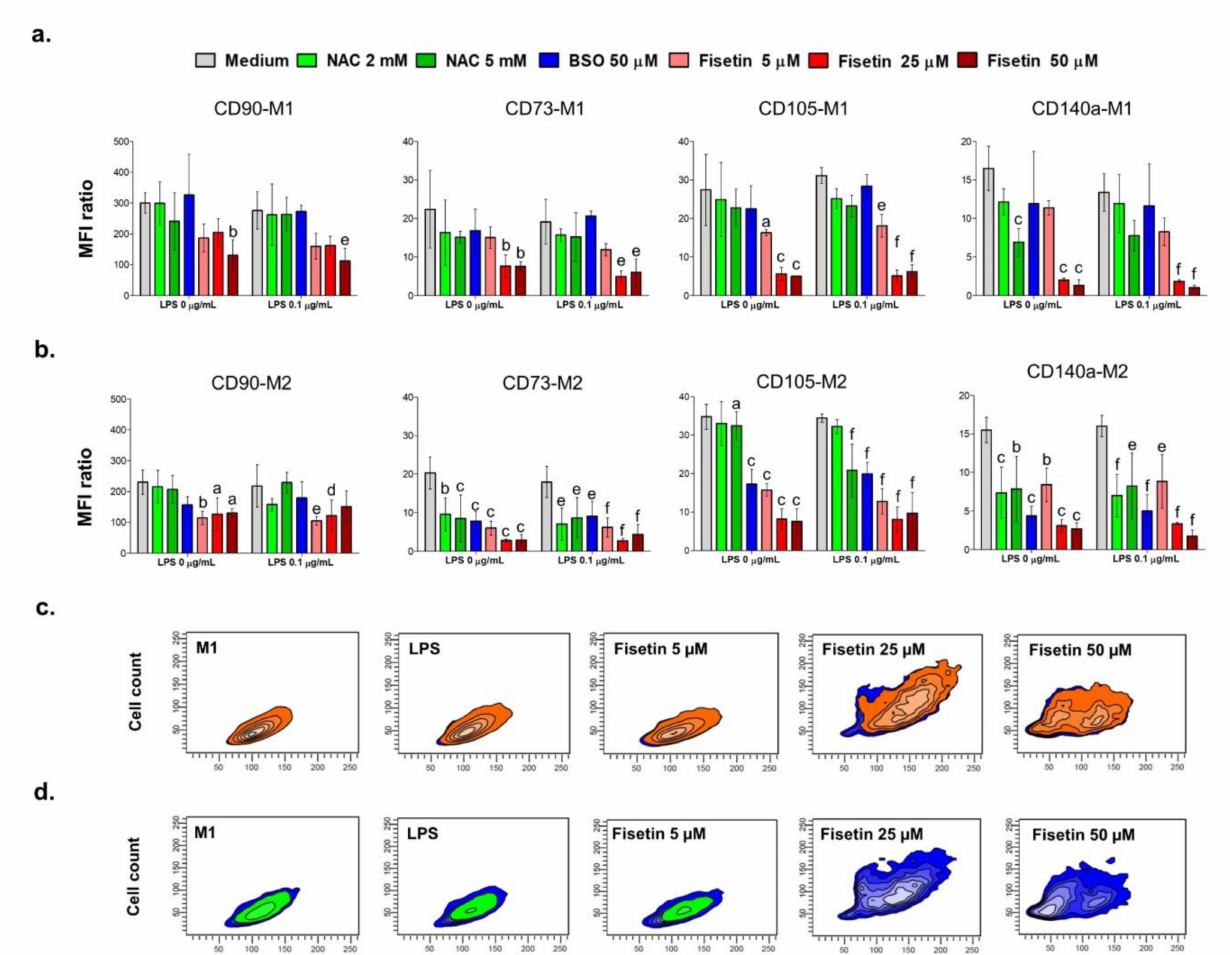
Figure 3. Immunophenotypic profile of human pulp cells. Cell cultures were treated under various experimental conditions for 3 days. Mean fluorescence intensity ratios (MFI ratio) for surface markers CD90, CD73, CD105, and CD140a with M1 ( a ) and M2 ( b ) were obtained as described in the Materials and Methods section. Bars represent the MFI of the sample divided by the fluorescence intensity of related isotype controls as mean values ± standard deviations summarized from individual samples in two independent experiments (n = 4). M1 = complete growth medium; M2 = complete growth medium with dexamethasone and β -glycerophosphate. a = p < 0.01, b = p < 0.001 and c = p < 0.0001 between 0 µ M and treated samples without LPS (0 µ g/mL); d = p < 0.01, e = p < 0.001 and f = p < 0.0001 between LPS alone and treated samples in the presence of LPS (0.1 µ g/mL). For- ward scatter/Side scatter (FSC/SSC) density dot plots from one representative experiment represent the cell population CD73-positive in orange ( c ), CD140a positive in green ( d ) and unstained in blue. The immunophenotypic profile of human pulp cells is weakly influenced by LPS and strongly modulated by